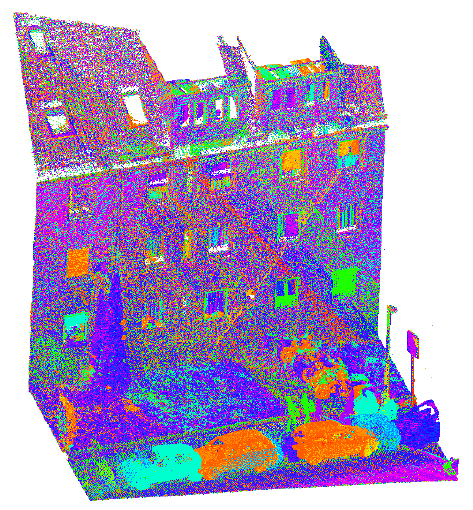
Figure 8. Point cloud consisting of multiple scans, using a random color for each scan.